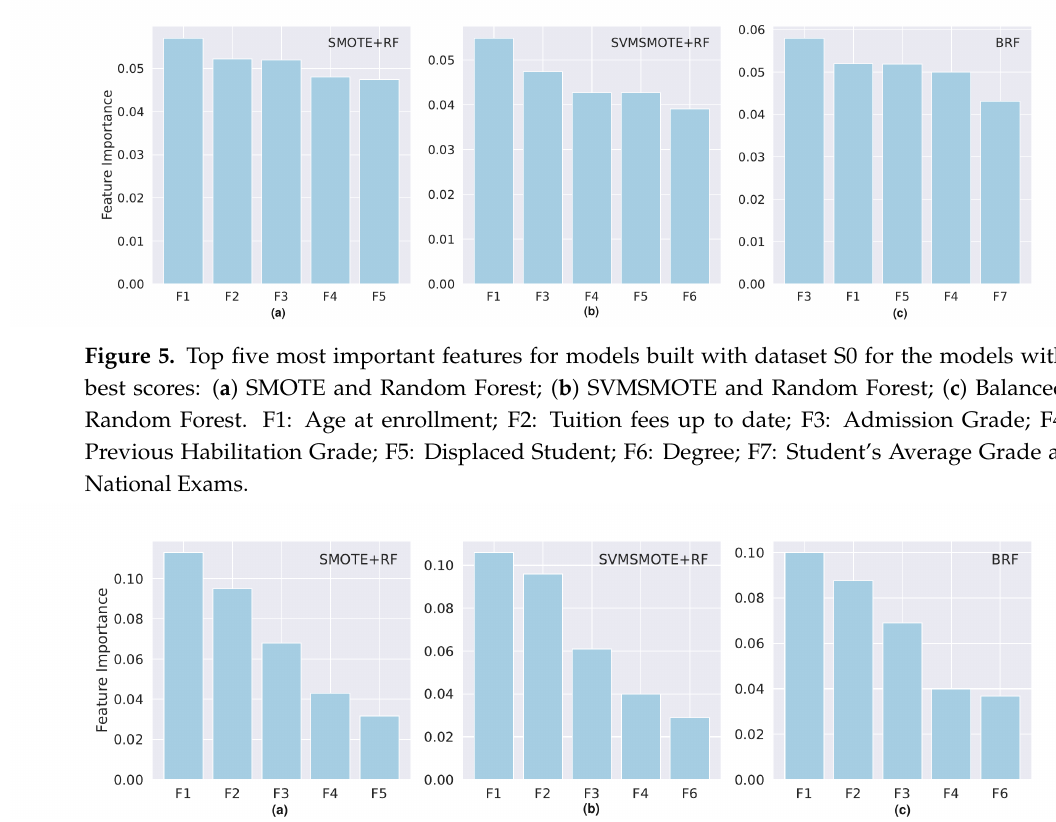
Figure 6. Top five most important features for models built with dataset S1 for the models with best